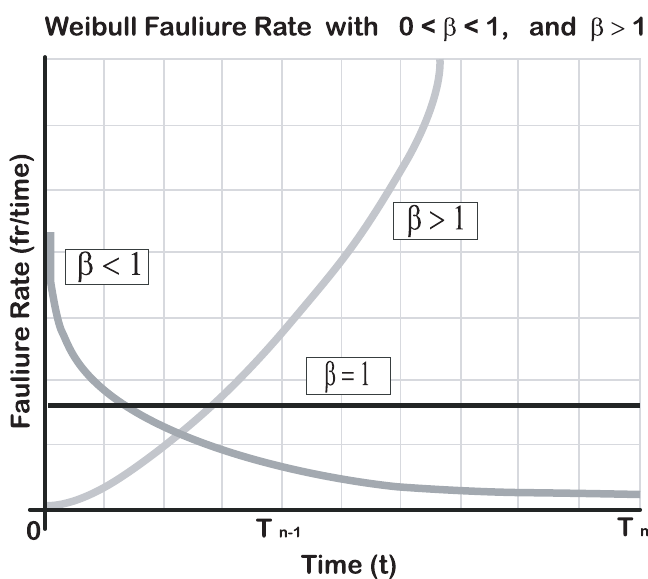
Figure 3. Weibull distribution. Adapted from the theories proposed by Ruiz et al.